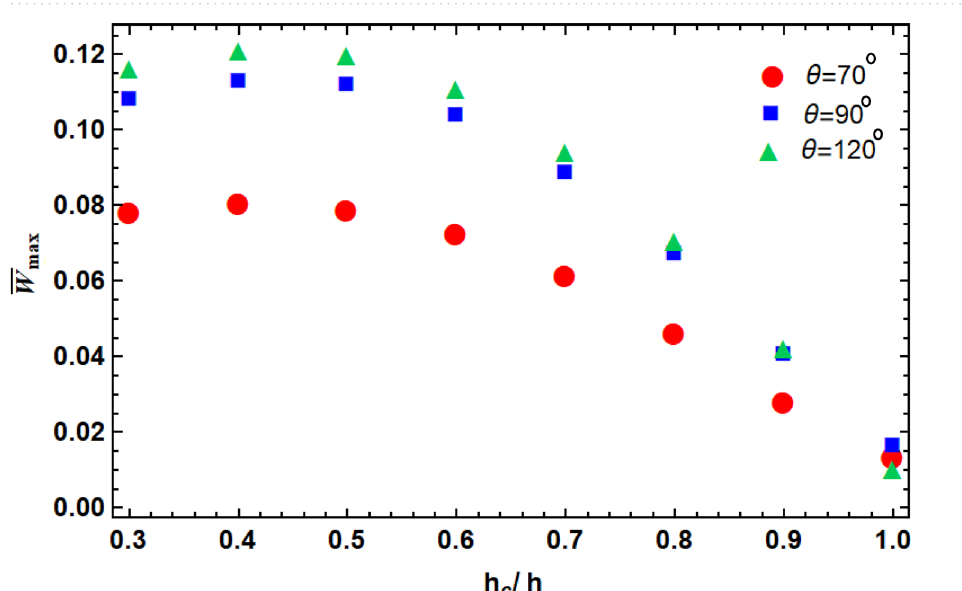
Figure 5. The normalized maximum deflection of re-entrant lattice core with different unit cell angles and out- of-plane